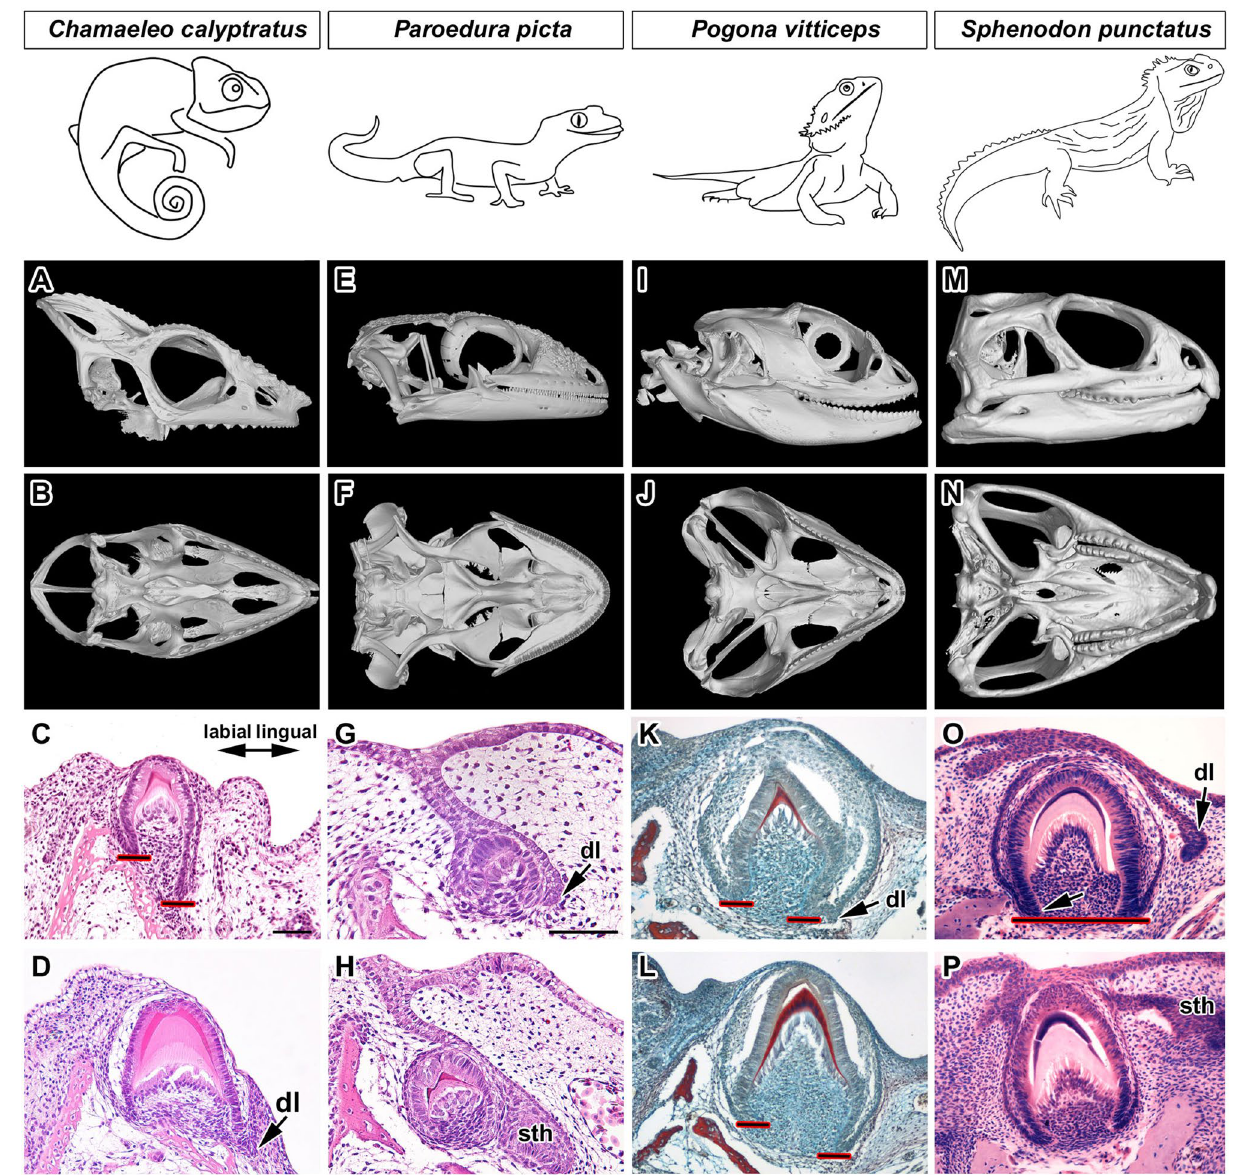
Figure 7. Comparison of tooth symmetry/asymmetry of selected reptilian species. ( A – D ) Chamaeleo calyptratus . ( A , B ) Lateral and palatal view of the skull of Chamaeleo calyptratus displaying complex teeth located in one row on the upper jaw. ( C , D ) Asymmetrical tooth germs at two different developmental stages. ( E – H ) Paroedura picta . ( E – F ) Lateral and palatal view of the skull of Paroedura picta displaying complex teeth located in one row on the upper jaw. ( G , H ) Asymmetrical tooth germs at two different developmental stages. ( I – L ) Pogona vitticeps . ( I , J ) Lateral and palatal view of the skull of Pogona vitticeps displaying complex teeth located in one row on the upper jaw. ( K , L ) Asymmetry in the development of the cervical loop was evident in acrodont tooth germs developing in the posterior area ( L ) of the jaw during mineralization stages at day 55 post- oviposition. ( M – P ) Sphenodon punctatus . ( M , N ) Lateral and palatal view of the skull of Sphenodon punctatus displaying complex teeth located in two rows posteriorly on the upper jaw. The teeth of the lower jaw fit into the groove between the two rows of teeth on the upper jaw. ( O , P ) Symmetrical tooth germs were observed in both the posterior ( O ) and more anterior ( P ) regions of the jaw. Specimen R, 5 months old. dl dental lamina, sth successional tooth, black line with red outlines ending of the cervical loop. Scale bar = 50